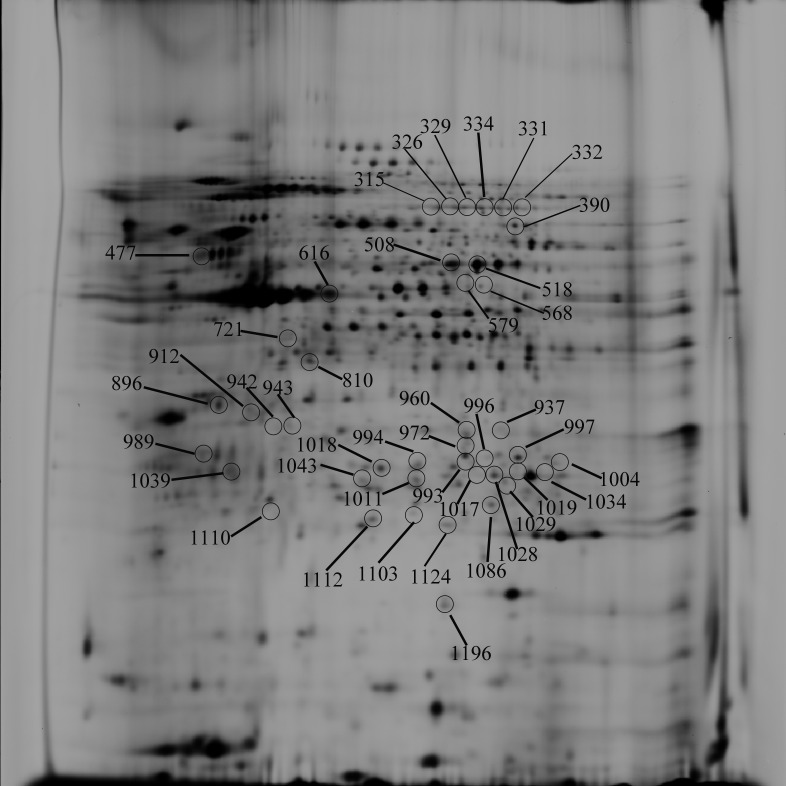
2D-DIGE analysis of PRRSV-infected PAMs and mock-infected PAMs.Arrows indicate isolated and identified protein spots that were up- or downregulated by at least 1.2-fold (P<0.01). Spots are numbered according to Table 3. Equal amounts of total protein from infected and uninfected whole cell lysates were resolved by 2D-DIGE.